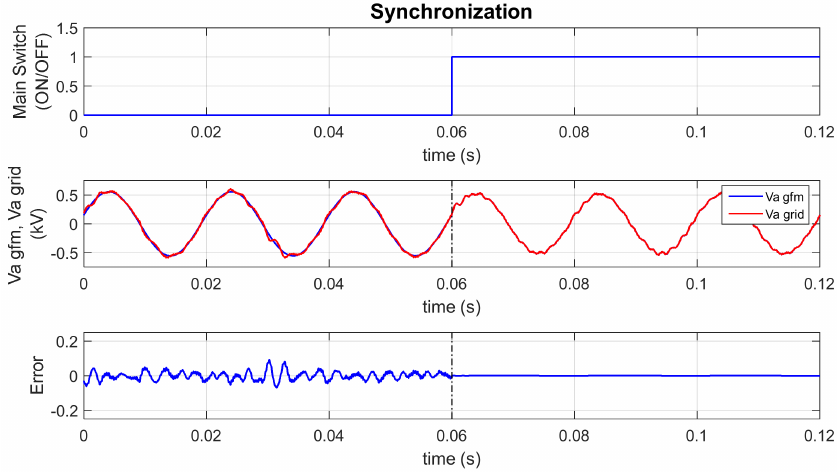
Figure 15. Grid synchronization signal and GFM converter